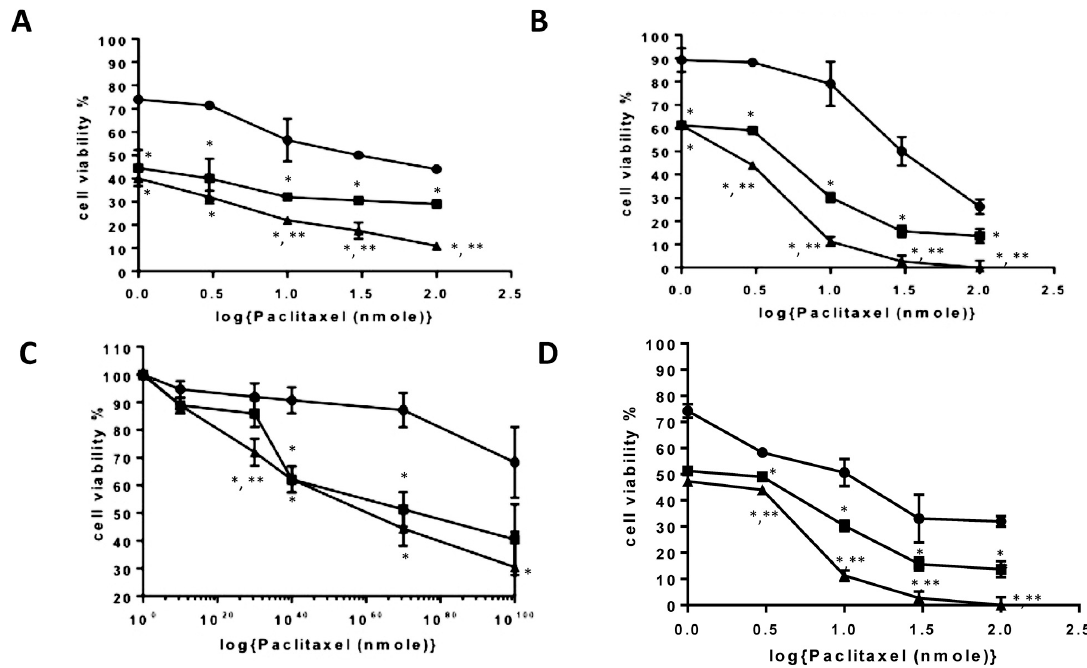
Figure 6. Cytotoxicity of formulations in ( A ) hepatocellular carcinoma cell line (HepG2), ( B ) Huh-7D12, ( C ) SK-hep-1 and ( D ) U937 cells after 72 h exposure to PTX alone and after encapsulation inside amphiphiles ( n = 3, ± SD). PTX, (cid:4) PAA-Ox5+PTX, (cid:78) PAA-Ox5-HNPc+PTX. * denotes significance